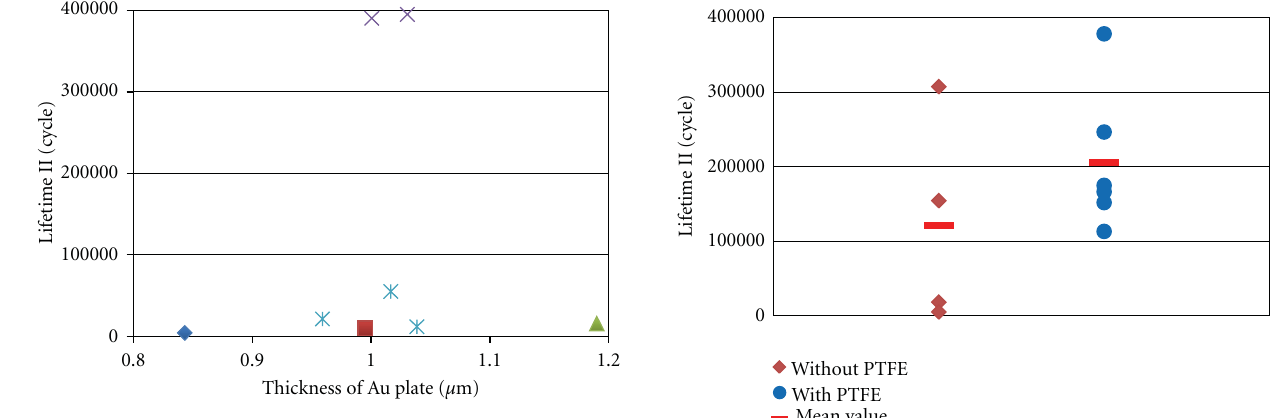
Figure 13: The lifetime and the thickness of gold platings.